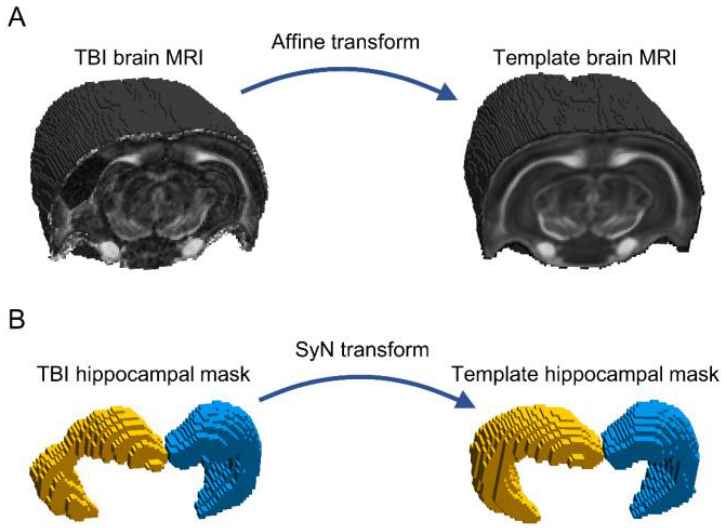
Figure 3. Image registration. ( A ) Each brain was registered into the whole brain sham template, using an affine registration. ( B ) Then, the segmented ipsilateral (left, yellow) and contralateral (right, blue) hippocampal masks were registered into the hippocampal template masks, using symmetric image normalization registration (SyN). The parametric MRI maps were subsequently transformed to the template space, and the contributions of non-hippocampal voxels were suppressed to create the hippocampal images.